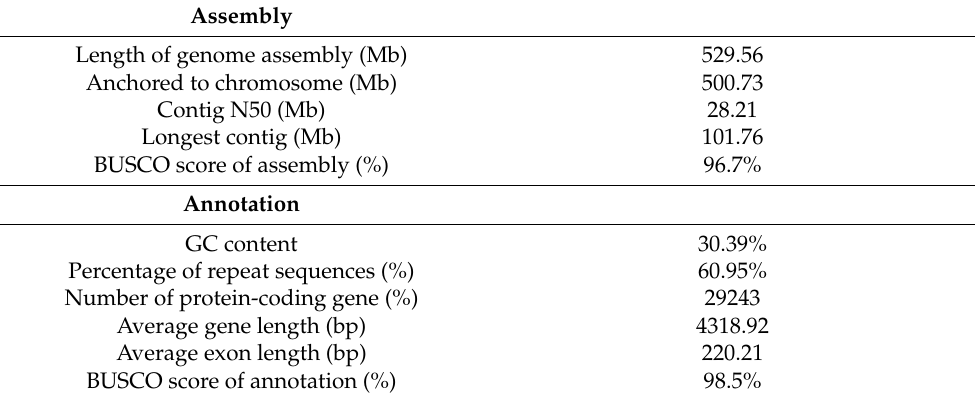
Table 1. Assembly and annotation statistics of E. moorcroftii